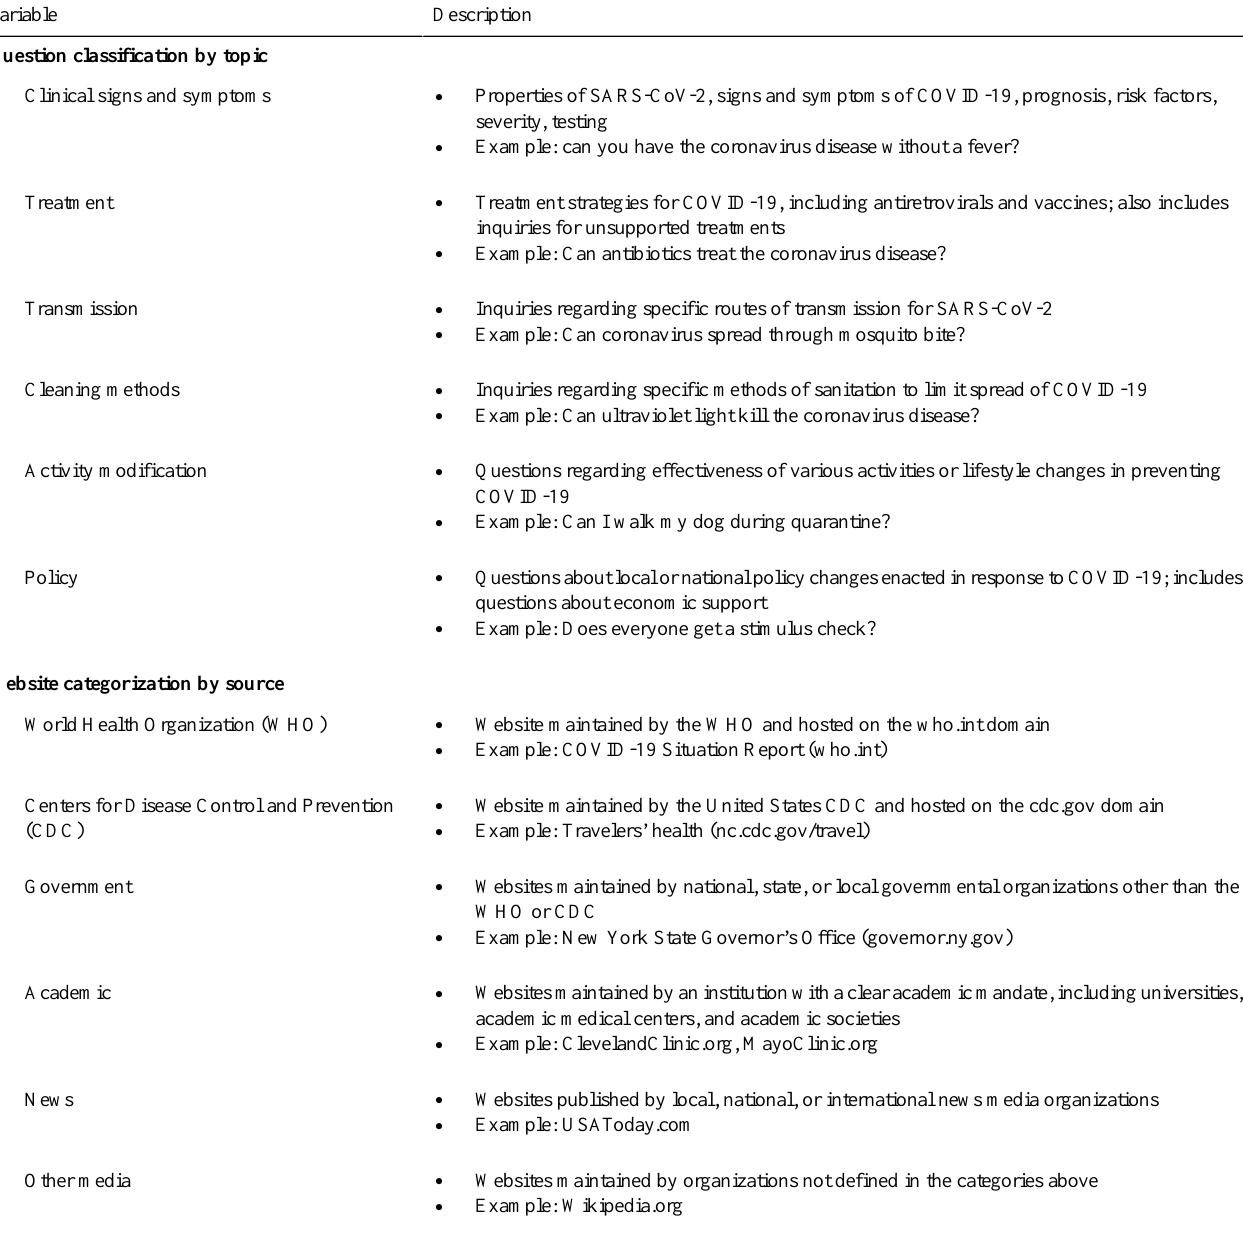
Table 1. Question classification by topic and website categorization by